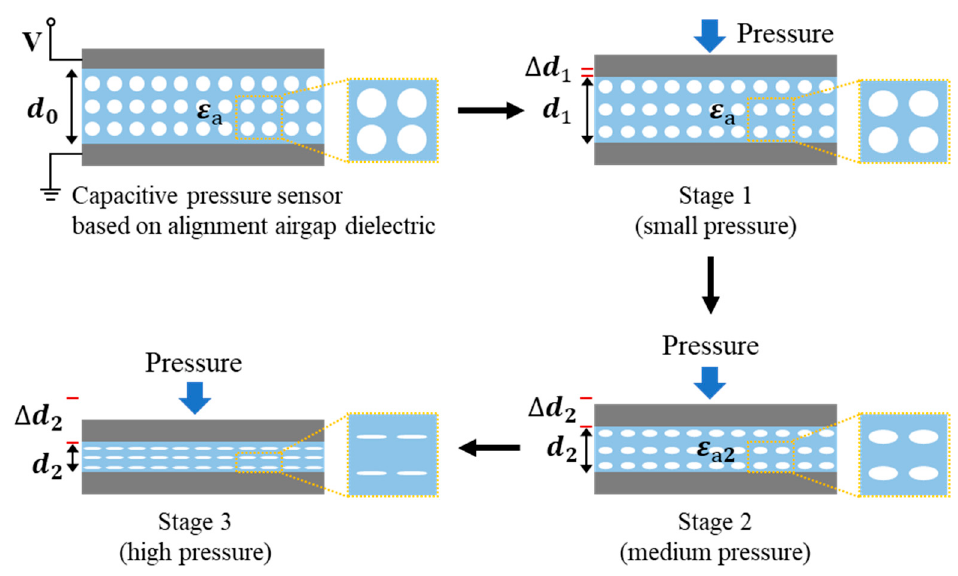
Figure 2. Schematic of the mechanism of the capacitive sensor using an alignment air gap elastomer as a dielectric layer.